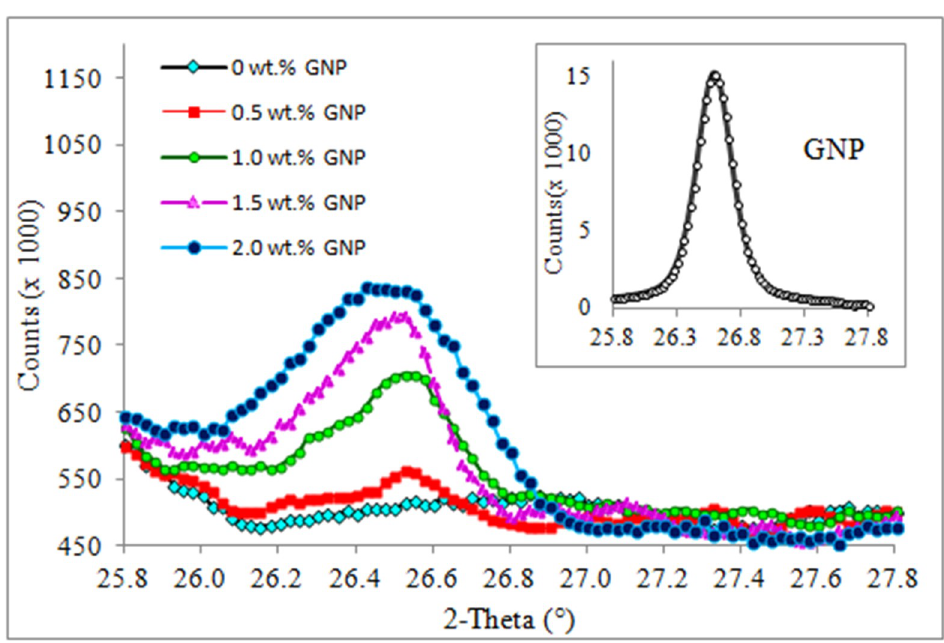
Fig 4. Effect of GNP weight fractions on the nanofillers dispersion in within TPNR matrix [Inset: XRD pattern for pristine GNP].